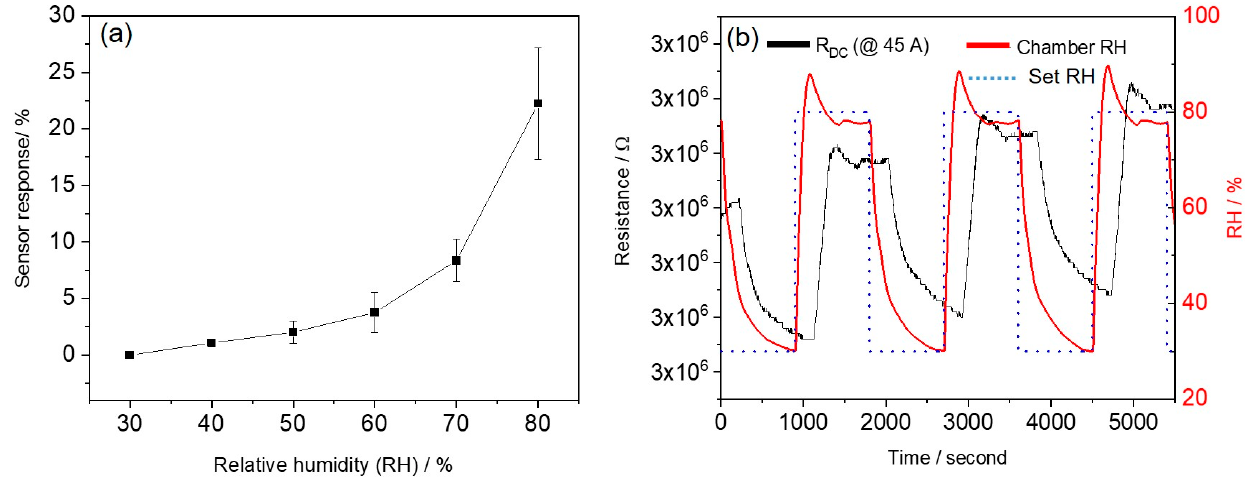
Figure 6. ( a ) Response of a humidity sensor based on carbon fibres (45 A) as a function of relative humidity; ( b ) dynamic response and recovery of this sensor during cycling between 30% and 80% relative humidity (RH).